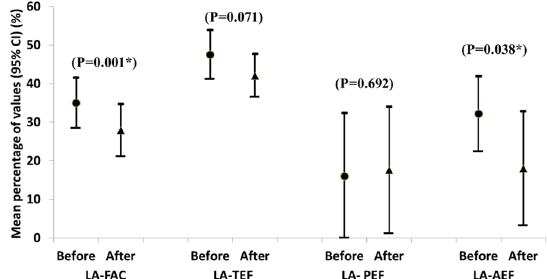
Fig. 3 Comparative changes of left atrial volumetric function throughout the cardiac cycle before (filled circle) and after (filled triangle) 1 MAC sevoflurane anesthesia. LA-FAC (%); left atrial functional area change, LA-TEF (%); left atrial total emptying fraction (left atrial reservoir function %), LA-PEF (%); left atrial passive emptying fraction (left atrial conduit function %), LA-AEF (%); left atrial active pump function. * Denotes significance based on paired t test